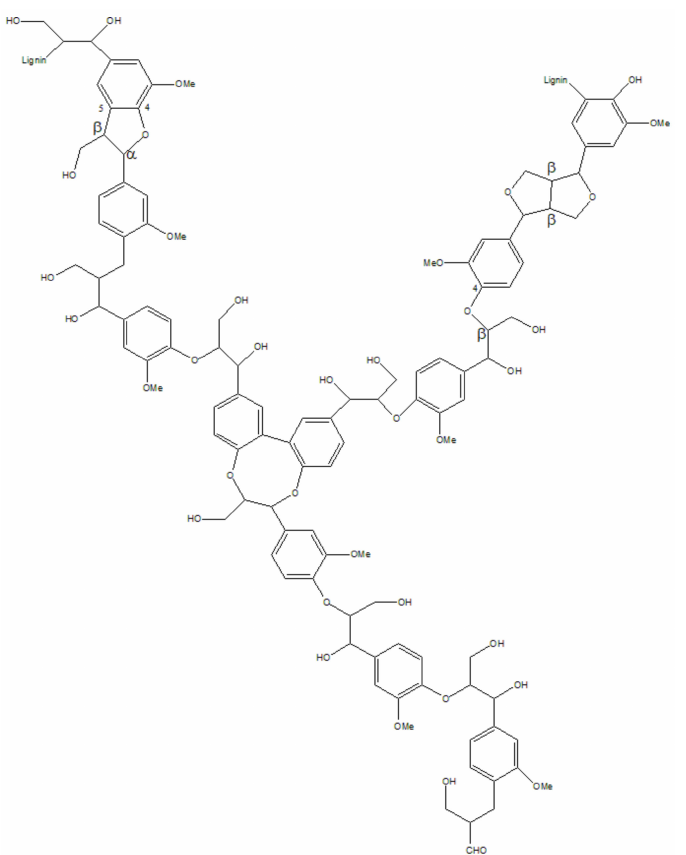
Figure 5. Lignin structure